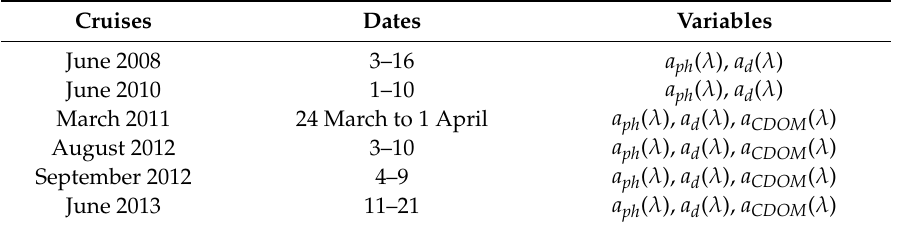
Table 1. General information of the oceanographic cruises and measured variables.